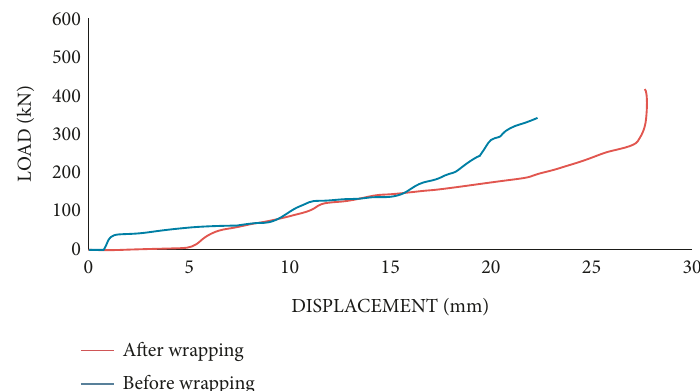
Figure 14: Load-deflection behavior of C specimens before and after wrapping.